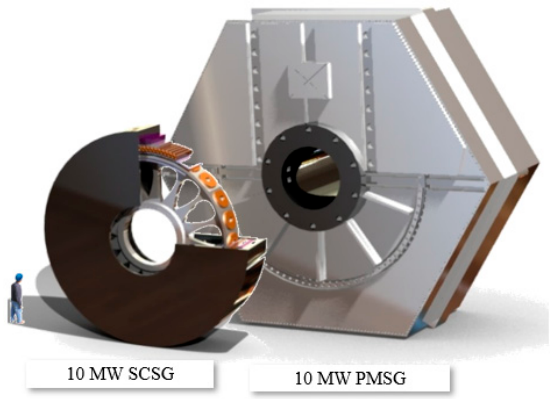
Figure 2. Comparison of the size of the permanent magnet synchronous generator (PMSG) and superconducting synchronous generator (SCSG) [14].